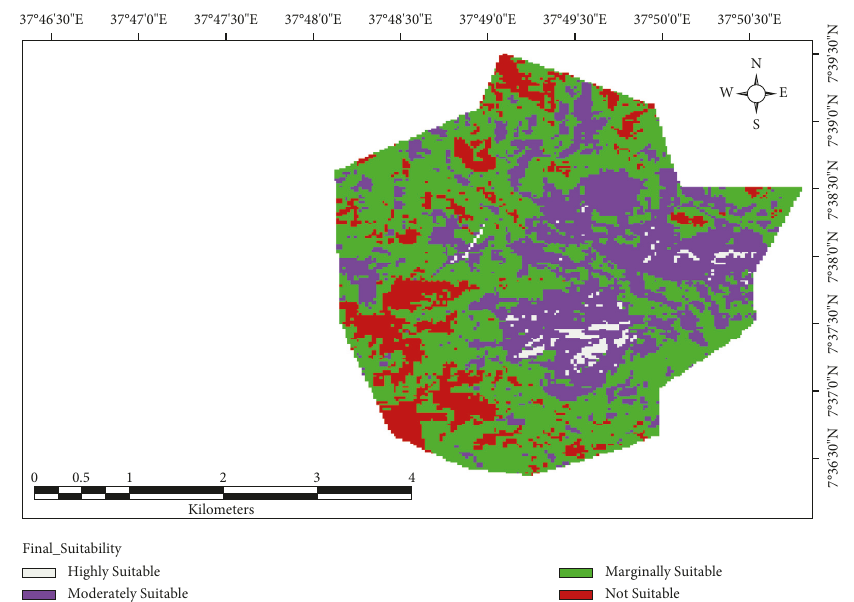
Figure 5: Final land suitability map of study areas for apple